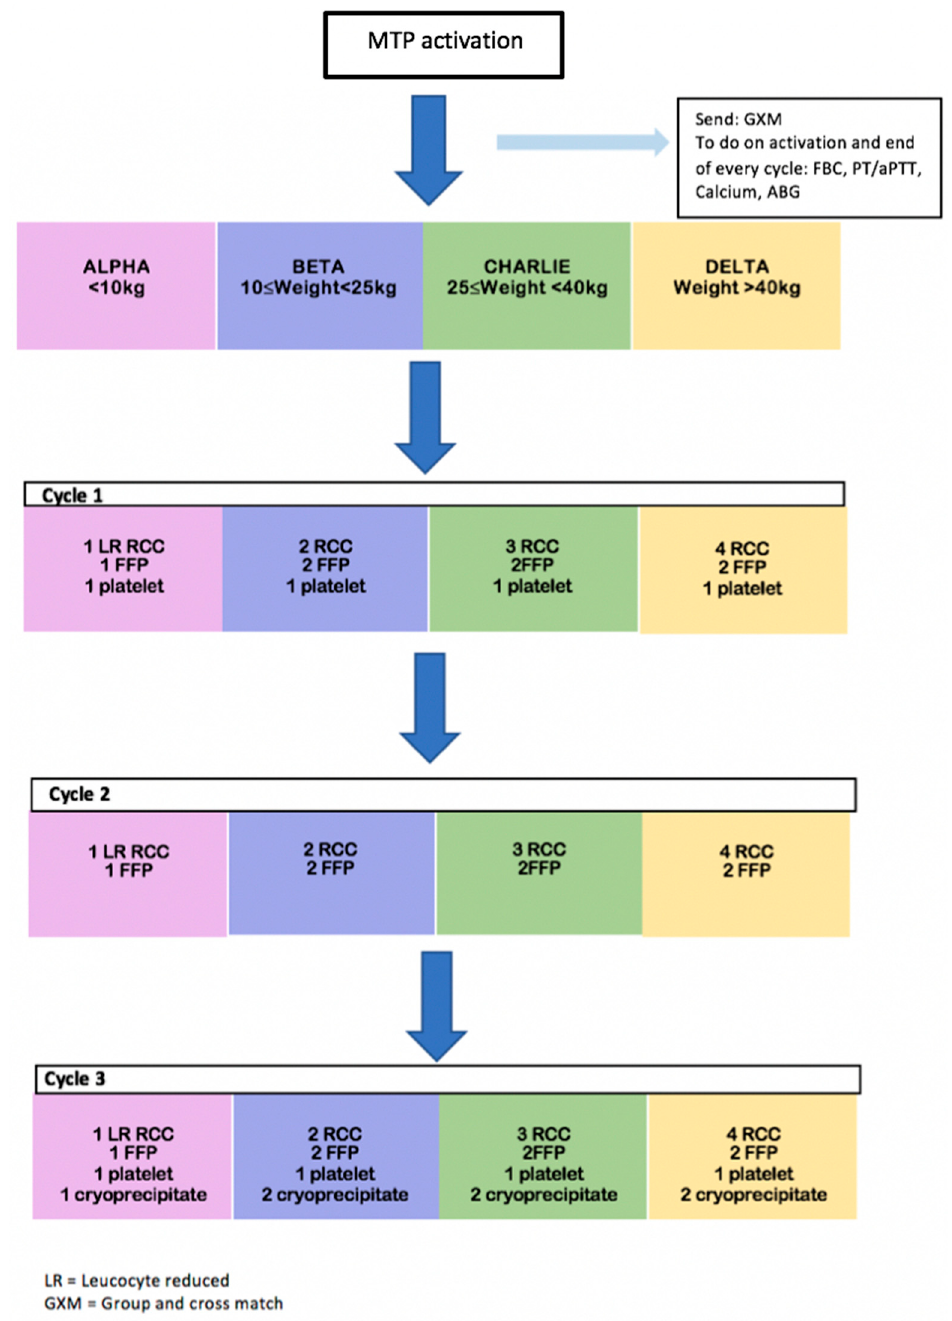
Figure 1. Composition of blood products for each paediatric MTP cycle.